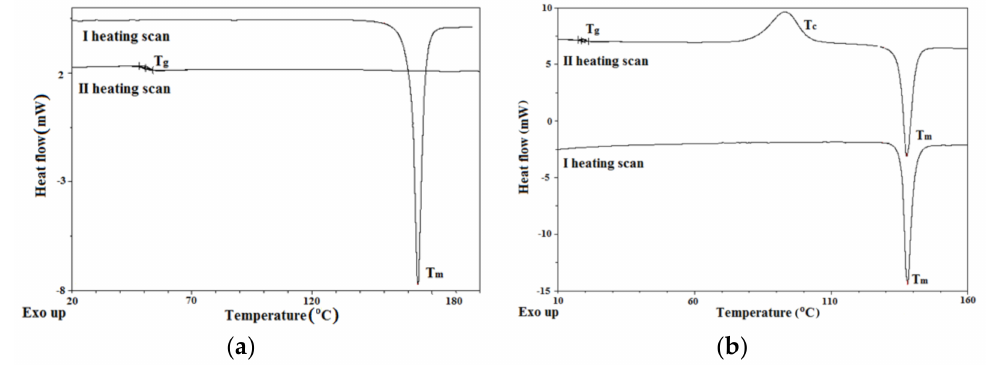
Figure 1. The differential scanning calorimetry (DSC) thermograms of ( a ) AzNI-2 and ( b )